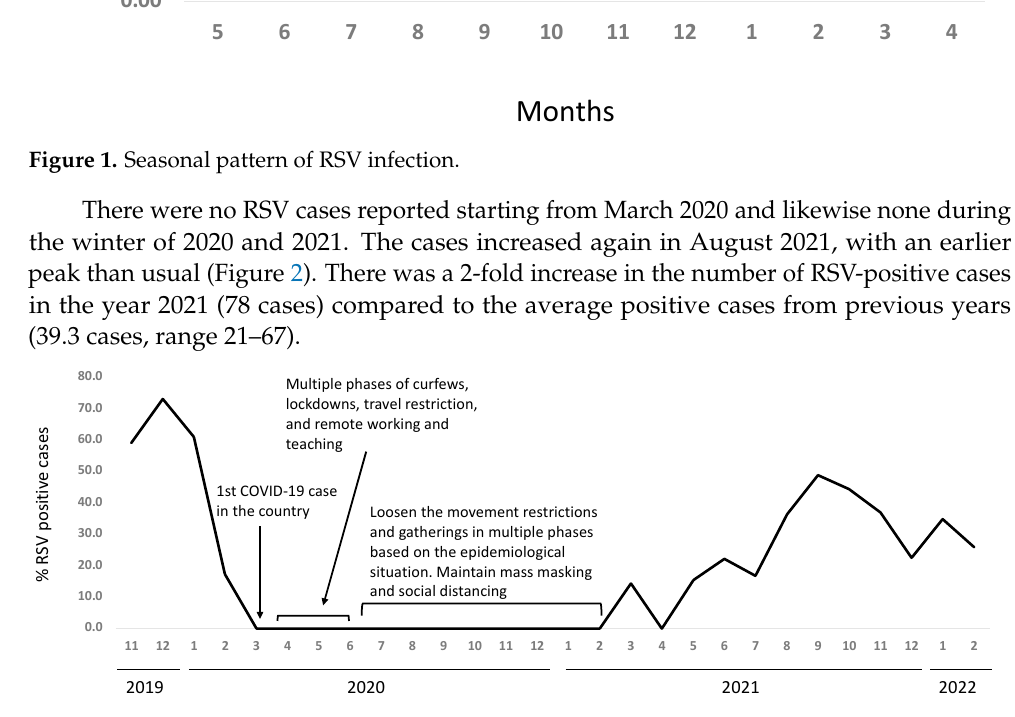
Figure 2. Seasonal pattern of RSV infection during and after the COVID-19 pandemic.